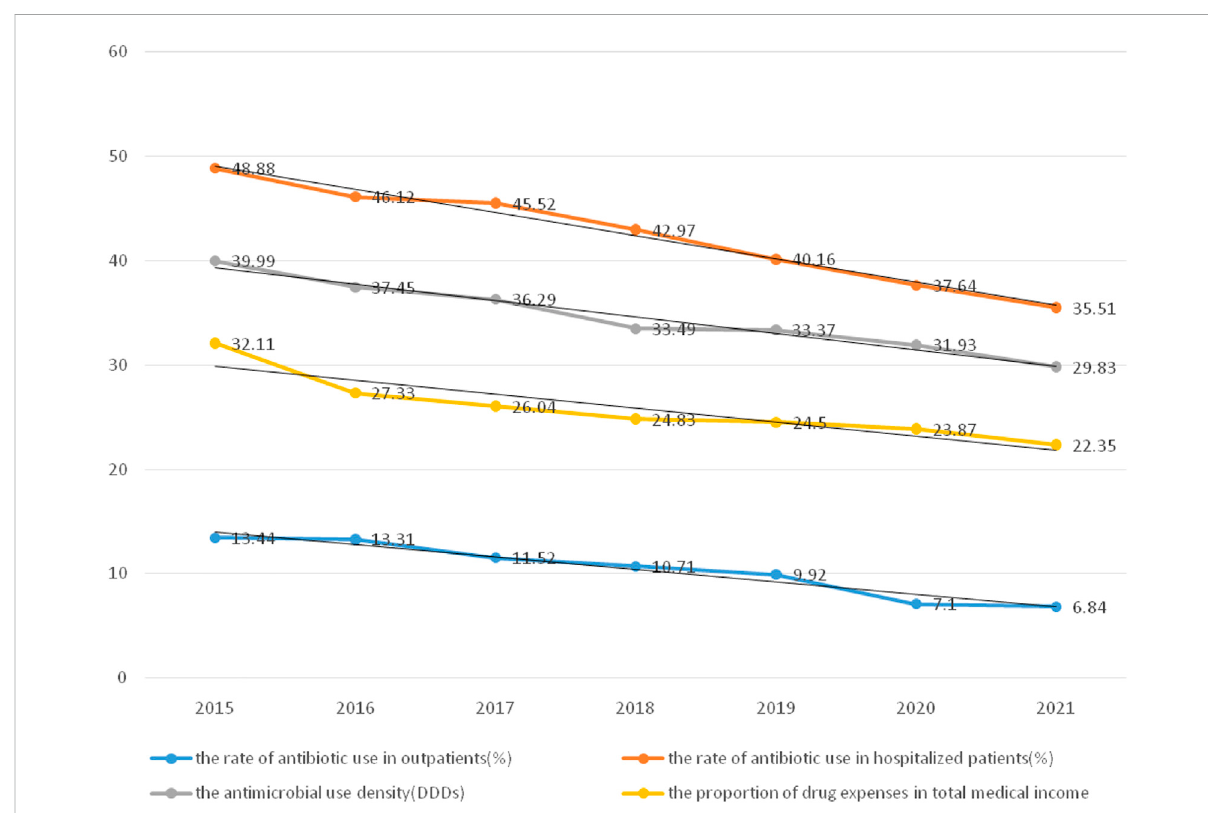
FIGURE 2 The utilization rate of antibiotics and the proportion of drug expenses from 2015 to 2021.